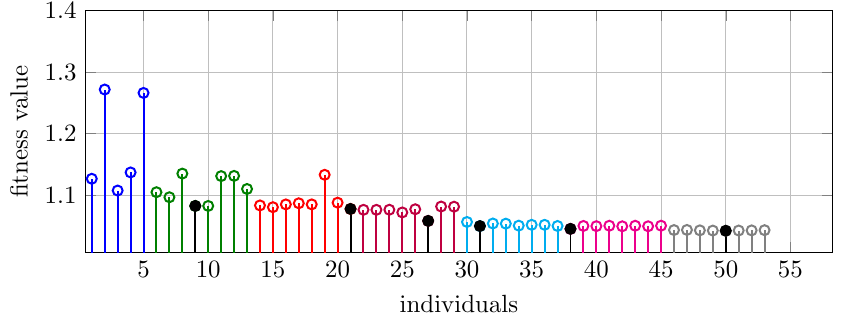
Figure 10. Fitness value of the different individuals along the generations. The different colors denote the different generations. The first group is the initial generation with five individuals. In each generation, the individual with the best fitness value is denoted by black filled marker. (five element initial population, G max = 6, N max = 8 and γ =